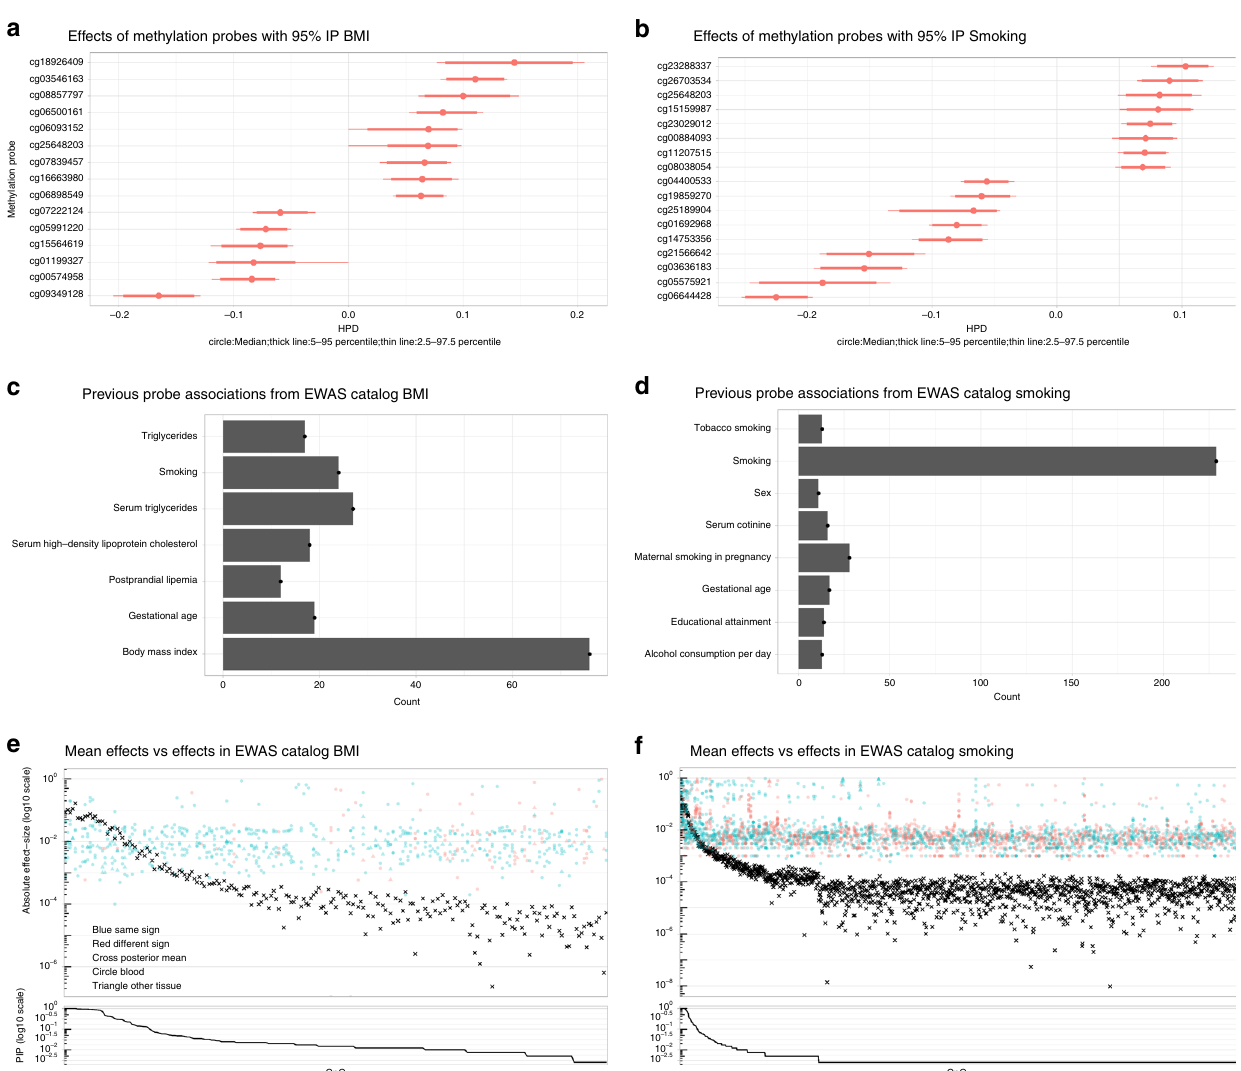
Fig. 3 Annotation replication and enrichment analysis. a , b Posterior distribution of effect sizes for methylation probes with 95% posterior inclusion probability (IP) for BMI and smoking, respectively. c , d Previous associations found for the probes with 95% IP according to the EWAS catalog. e , f Comparison between mean effect sizes of probes with Posterior Inclusion Probability (PIP) > 0 and effect sizes from literature in the EWAS catalog. Each cross represents the mean of the posterior estimates, colored point represents an effect size from the EWAS catalog, with blue indicating that the effect size had the same sign as our estimates, in red the contrary case. The shape of the point indicates in which tissue this effect was computed from, circle for Blood and triangle for other tissues. We notice how the agreement between our estimates and literature diminishes as the PIP diminishes, as in our case regularization protects us against overestimation of small